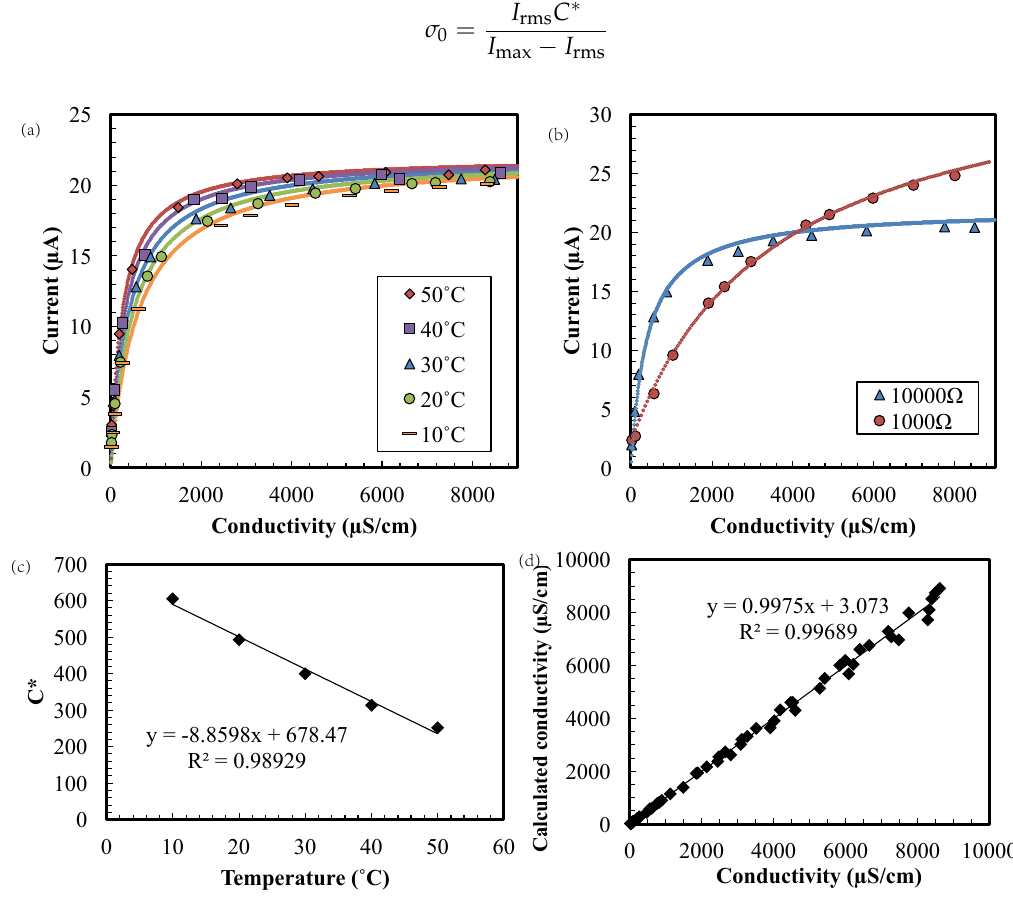
Figure 2. The root-mean-square (rms) current versus conductivity ( a ) in 10–50 ◦ C water with 10 k Ω and ( b ) with 1 k Ω and 10 k Ω in 30 ◦ C. ( c ) The constant C* versus temperature and ( d ) Measurement calculation with Equation